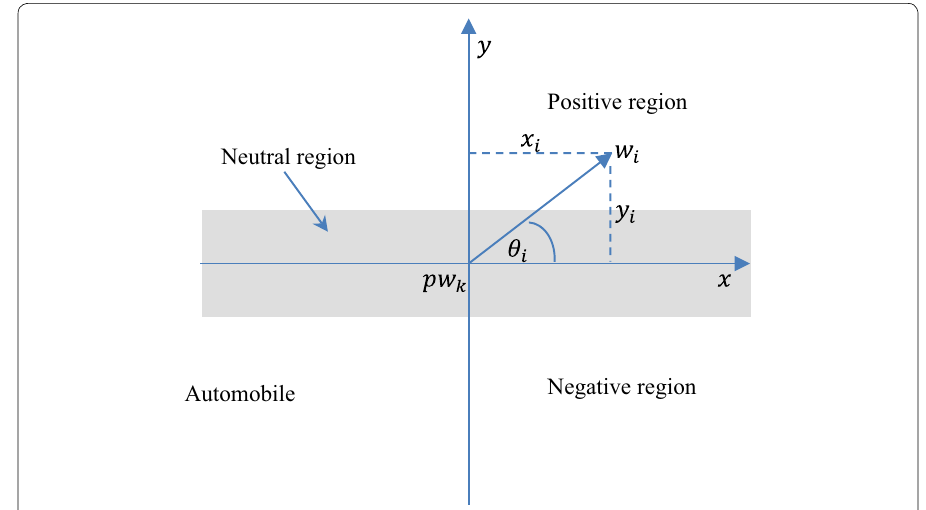
Fig. 3 Representation of Senticircle in Cartesian coordinate system